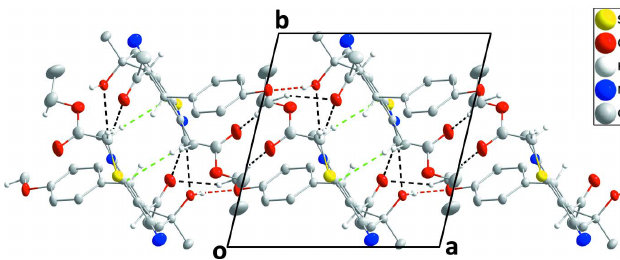
Figure 2 A portion of one chain viewed along the b -axis direction. O—H (cid:2)(cid:2)(cid:2) O and C—H (cid:2)(cid:2)(cid:2) O hydrogen bonds are depicted by red and black dashed lines, respectively.